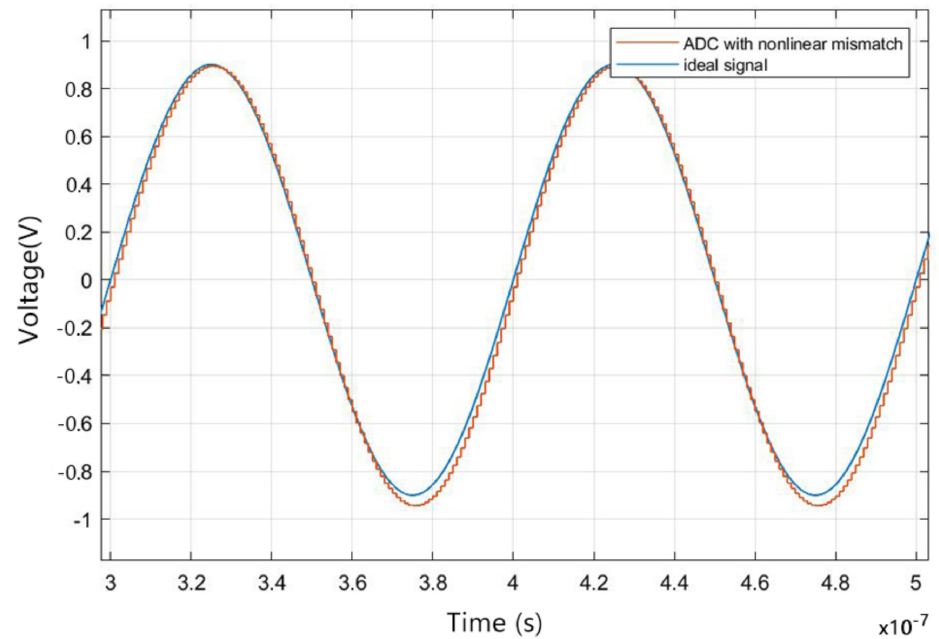
Figure 6. The time-domain figure of a single ADC with a nonlinear